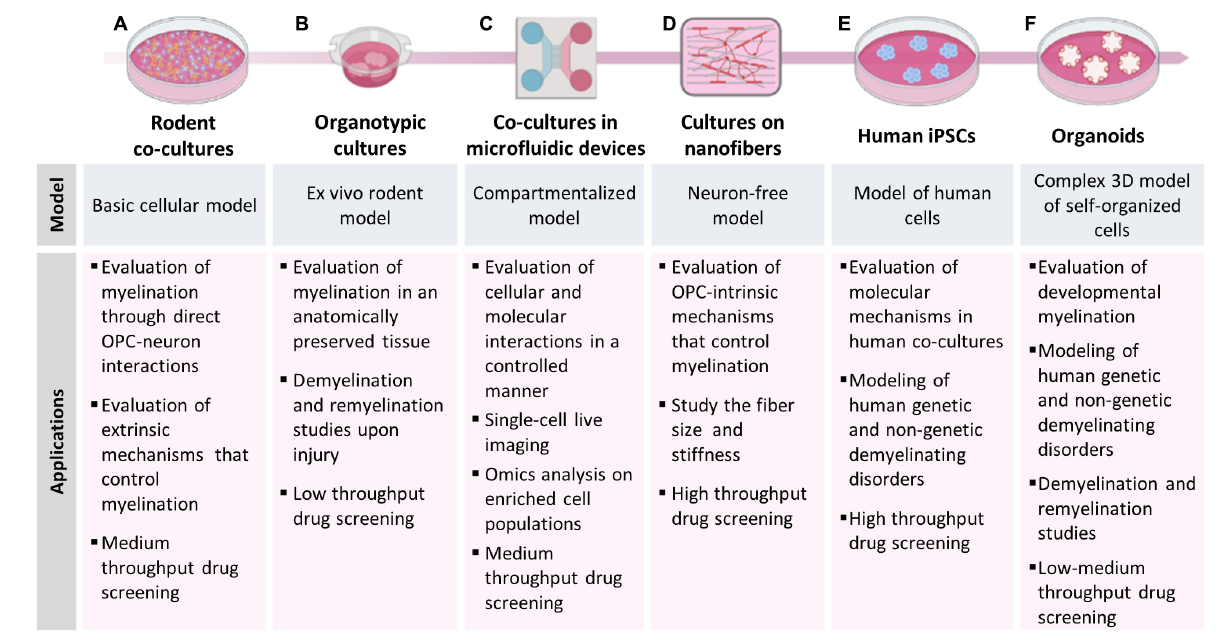
FIGURE 1 | Models to study myelination, demyelination and remyelination. The picture shows the different models of myelination described in the manuscript and their main applications. (A) Rodent co-cultures are easy to set-up, relatively inexpensive and can be used to study mechanisms involving OPC-neuron interactions and to evaluate the effect of candidate compounds in low-medium throughput drug screening. (B) Organotypic cultures allow to perform myelination studies in a more complex and anatomically preserved environment; the slices can be isolated from transgenic mice for fate-mapping studies, demyelinated with toxicants and used to test the remyelinating potential of candidate compounds. (C) Microfluidic devices induce neurons to project their axons into an adjacent compartment and form an aligned dense neurite network, on which OPCs can maturate and produce myelin; this model is particularly useful for single-cell live imaging analysis. (D) OPCs can also be cultured on bio-compatible nanofibers to study OPC-intrinsic mechanisms that control myelination. (E) The use of iPSCs from human subject allows to establish human co-cultures made of iPSC-derived OLs and neurons or (F) to generate brain organoids, providing in vitro models to study human